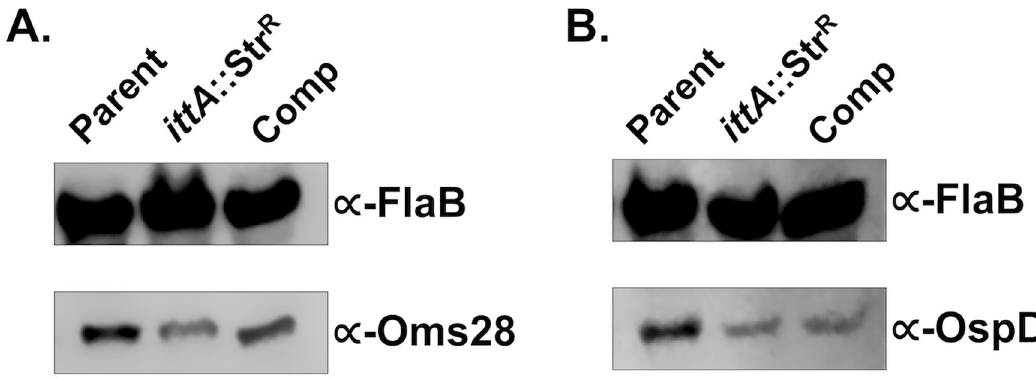
Fig 9. Evaluation of OspD and Oms28 in B . burgdorferi lacking ittA . Protein lysates were derived from parent, ittA sRNA mutant ( ittA :Str R ), and complement (Comp) strains grown under conditions that induce proteins important during mammalian infection in vitro and probed against anti-Oms28 (panel A) and anti-OspD (panel B). The production of FlaB was used as a loading control for both immunoblots shown.